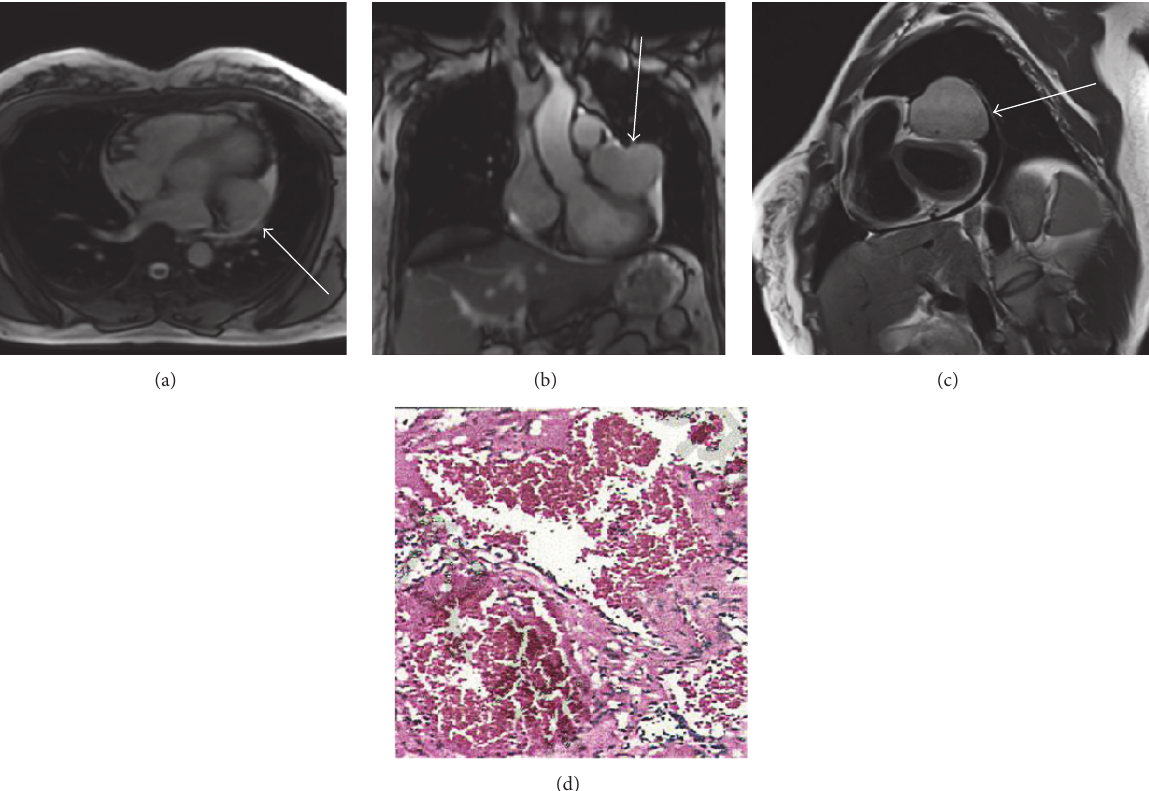
Figure 2: Cardiac magnetic resonance imaging showed a hypointense tumorous mass ((a), (b), and (c) arrows) extending from the internal wall of pericardium towards the adjacent wall of the left ventricle with a clear adipose line between the mass and the left ventricle. Pathology (d) showed cavernous hemangioma with some myocardial tissue denaturation, partial cardiac collagen degeneration, hypertrophy, and enlargement of the nucleus and immunostaining showed positive Ki-67 and negative SMA. Hematoxylin and eosin staining. Magnification, ×